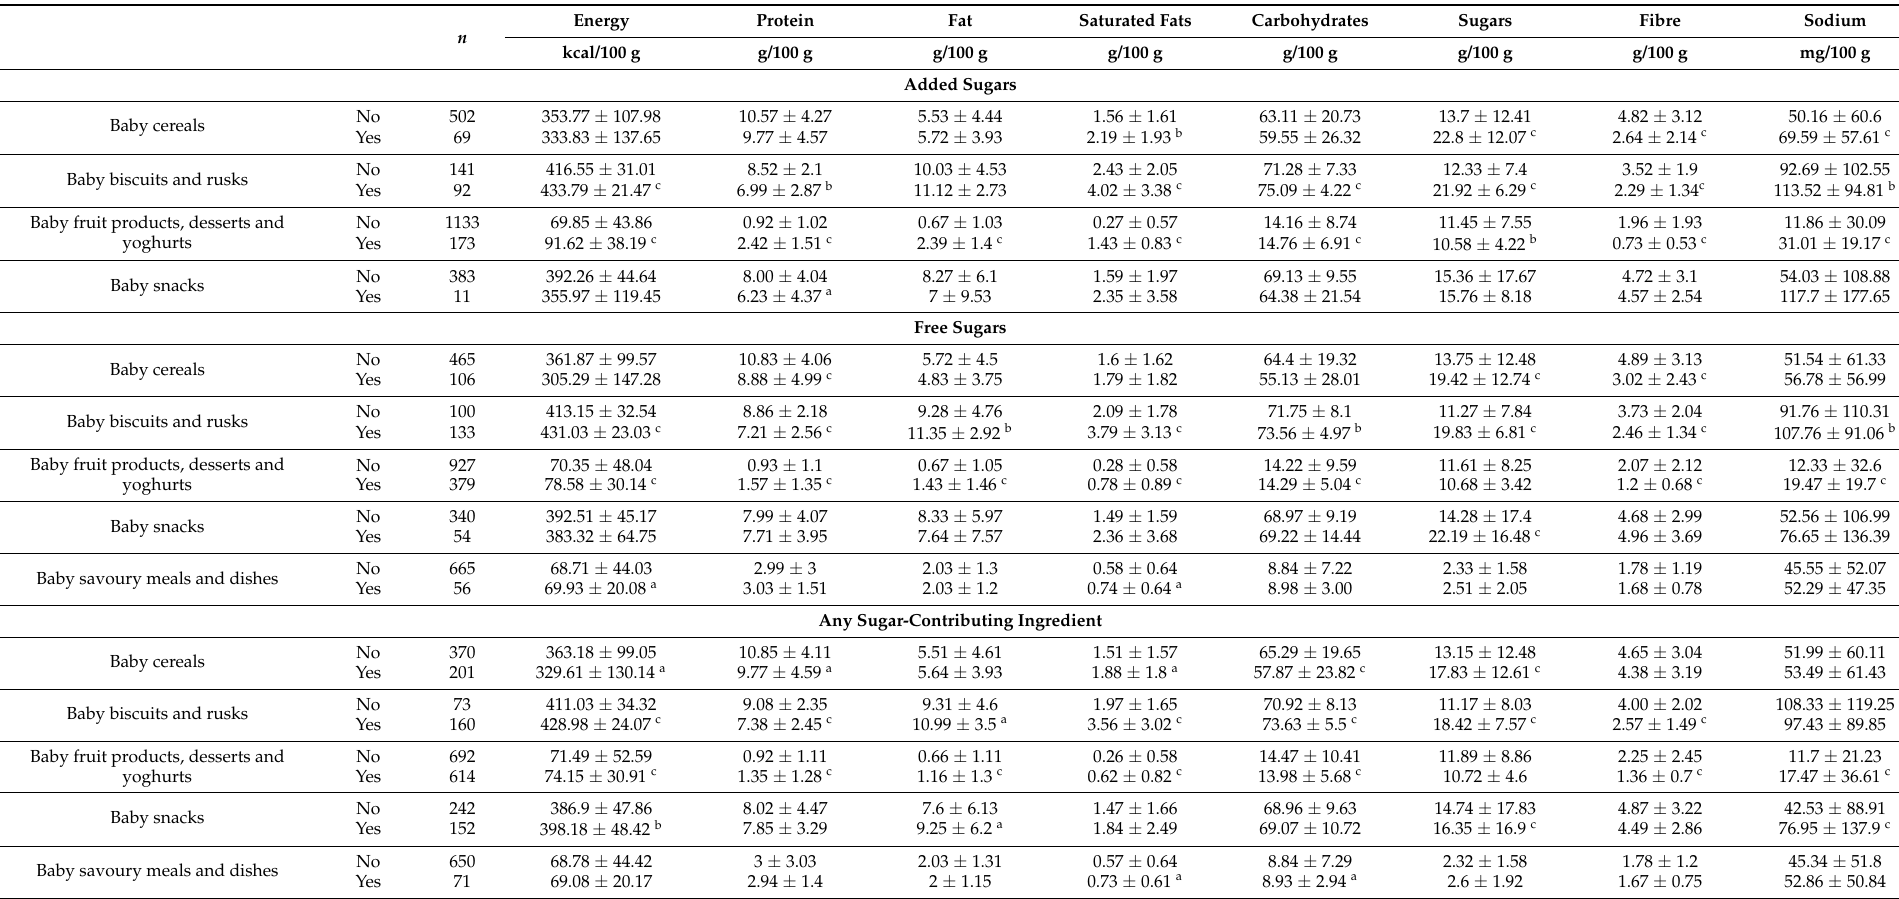
Table 3. Comparison of energy and nutrient content (mean ± s.d.) of products that did or did not contain added sugars, free sugars or any sugar-contributing ingredient, by baby food